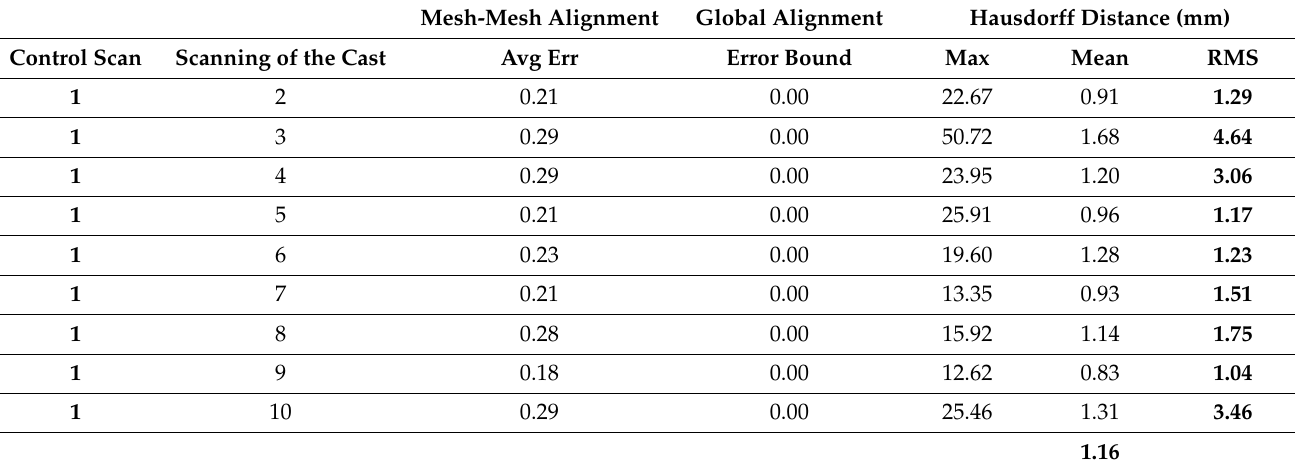
Table 3. Comparison of ten scans of the foot with a foot locking system and a tripod for the 3D